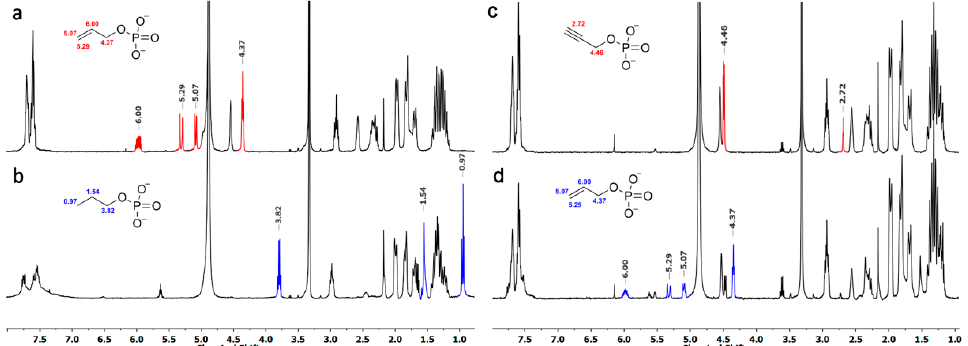
Figure 1. Shows 1 H NMR spectra of cyclohexylamine allyl phosphate 2 before ( a ) and after ( b ) hydrogenation, and of cyclohexylamine propargyl phosphate 1 before ( c ) and after ( d ) hydrogenation. To avoid the phase distortion and to simplify the comparison of the signal intensities, the spectra were registered after the hyperpolarization relaxed to the thermal polarization levels.